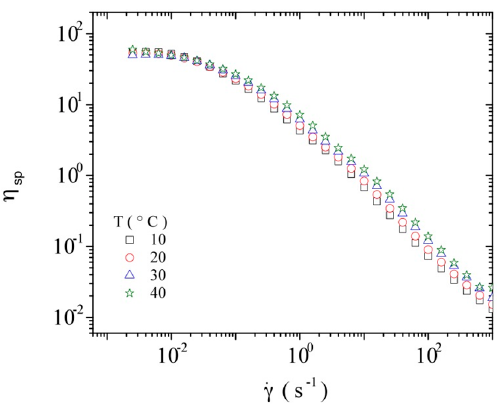
Figure 7. Influence of shear rate on the specific viscosity of calf-thymus DNA at a concentration of 7 mg/mL at the temperatures of 10, 20, 30, and 40 °C.